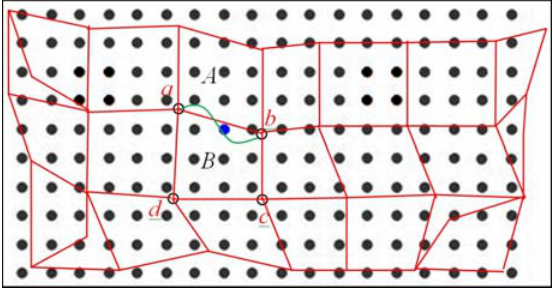
Figure 2. The tessellation pattern in raw image